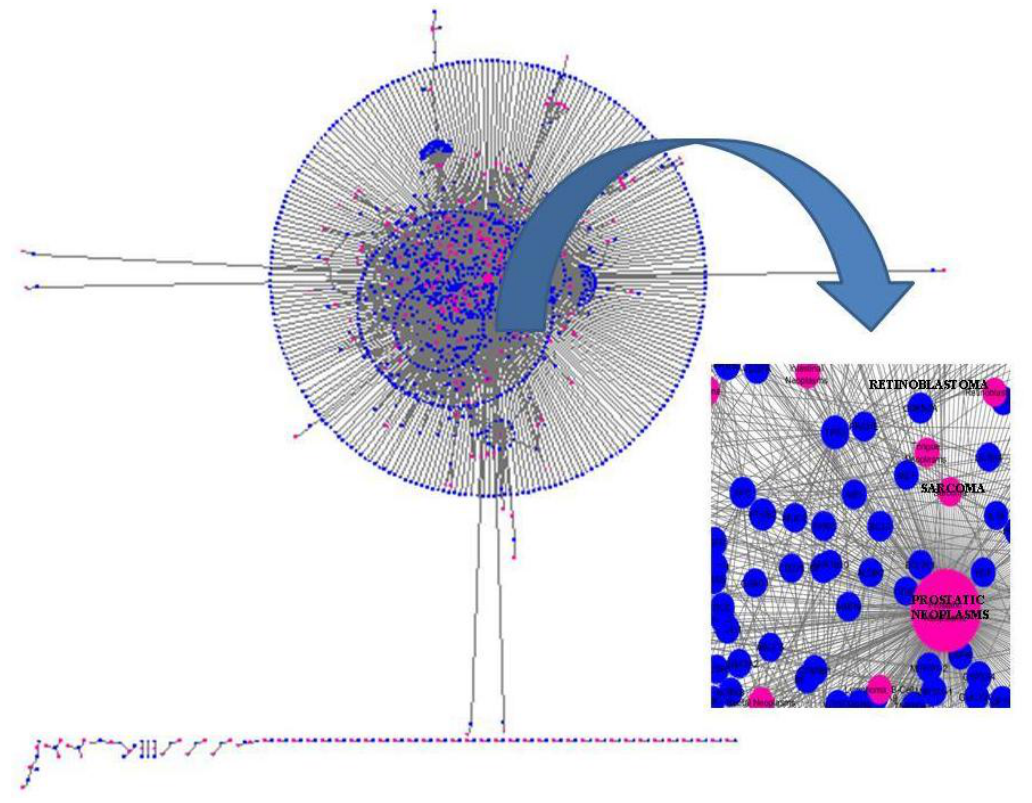
Figure 7. The ability to extract meaningful data from ever-expanding databases is an important area of development in computational oncology. Specifically, the relationship between genes and cancer is being documented by data-mining from large